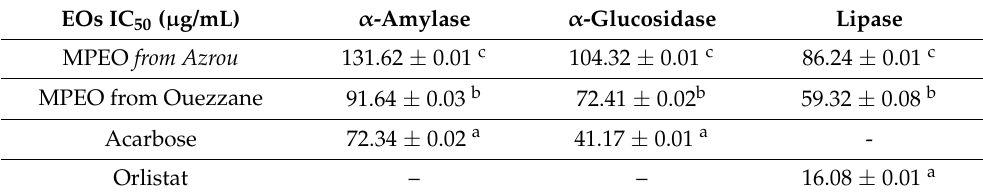
Different superscript letters in the same column indicate a significant difference ( p < 0.05).